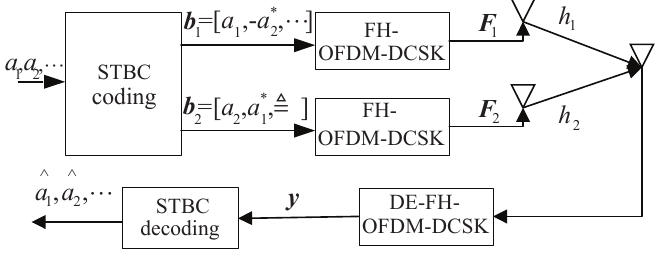
Figure 1. Transceiver structure of the 2 × 1 MIMO-FH-OFDM-DCSK